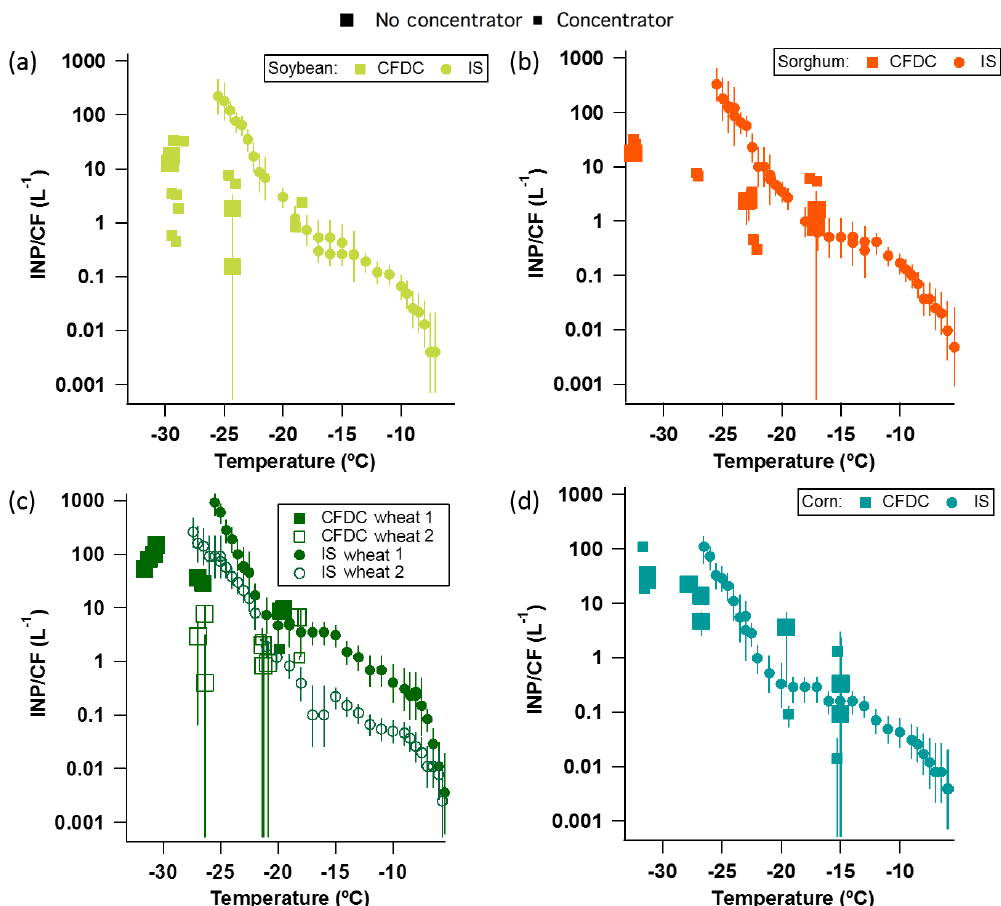
Figure 1. INP number concentrations divided by the concentration factor (CF) measured using the CFDC (squares) and IS (circles) during four harvests are shown as soybean (a) , sorghum (b) , wheat (c) , and corn (d) . The smaller squares represent particles sampled on the concentrator, while the larger squares are sampled without the concentrator. Both significant and non-significant data are shown. Panels (c) and (d) are data collected through a 2.5µm